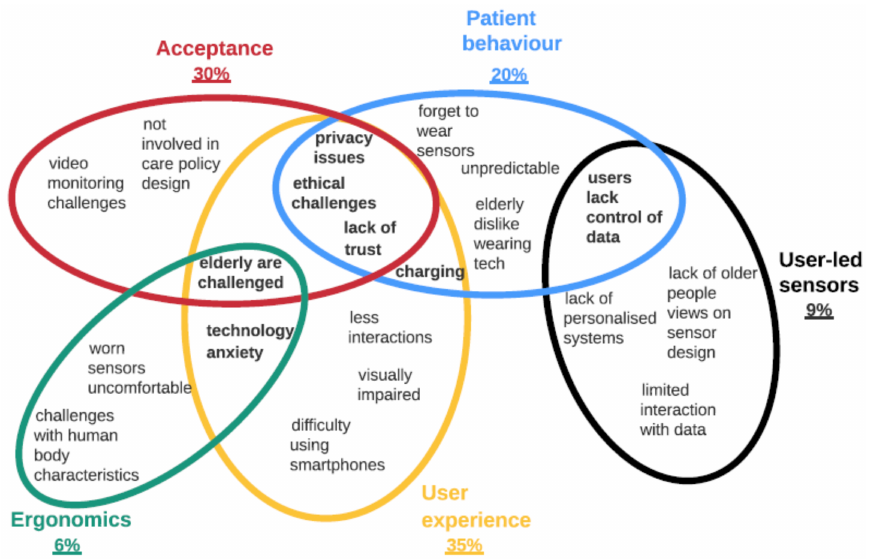
Figure 6. Highlighting design challenges in smart